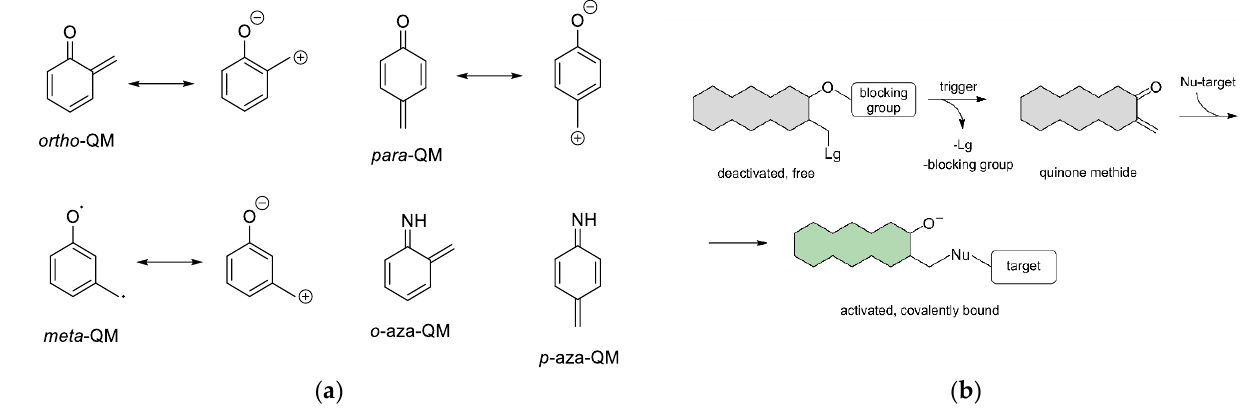
Figure 1. ( a ) Isomers of quinone methide and their zwitterionic resonance structure. Ortho - and para -aza-quinone methides. ( b ) Cartoon representation of QM generation.